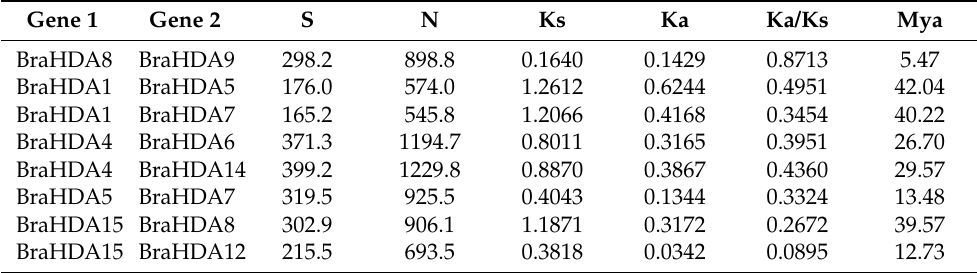
Table 2. Divergence between paralogous histone acetyltransferase gene pairs in Brassica